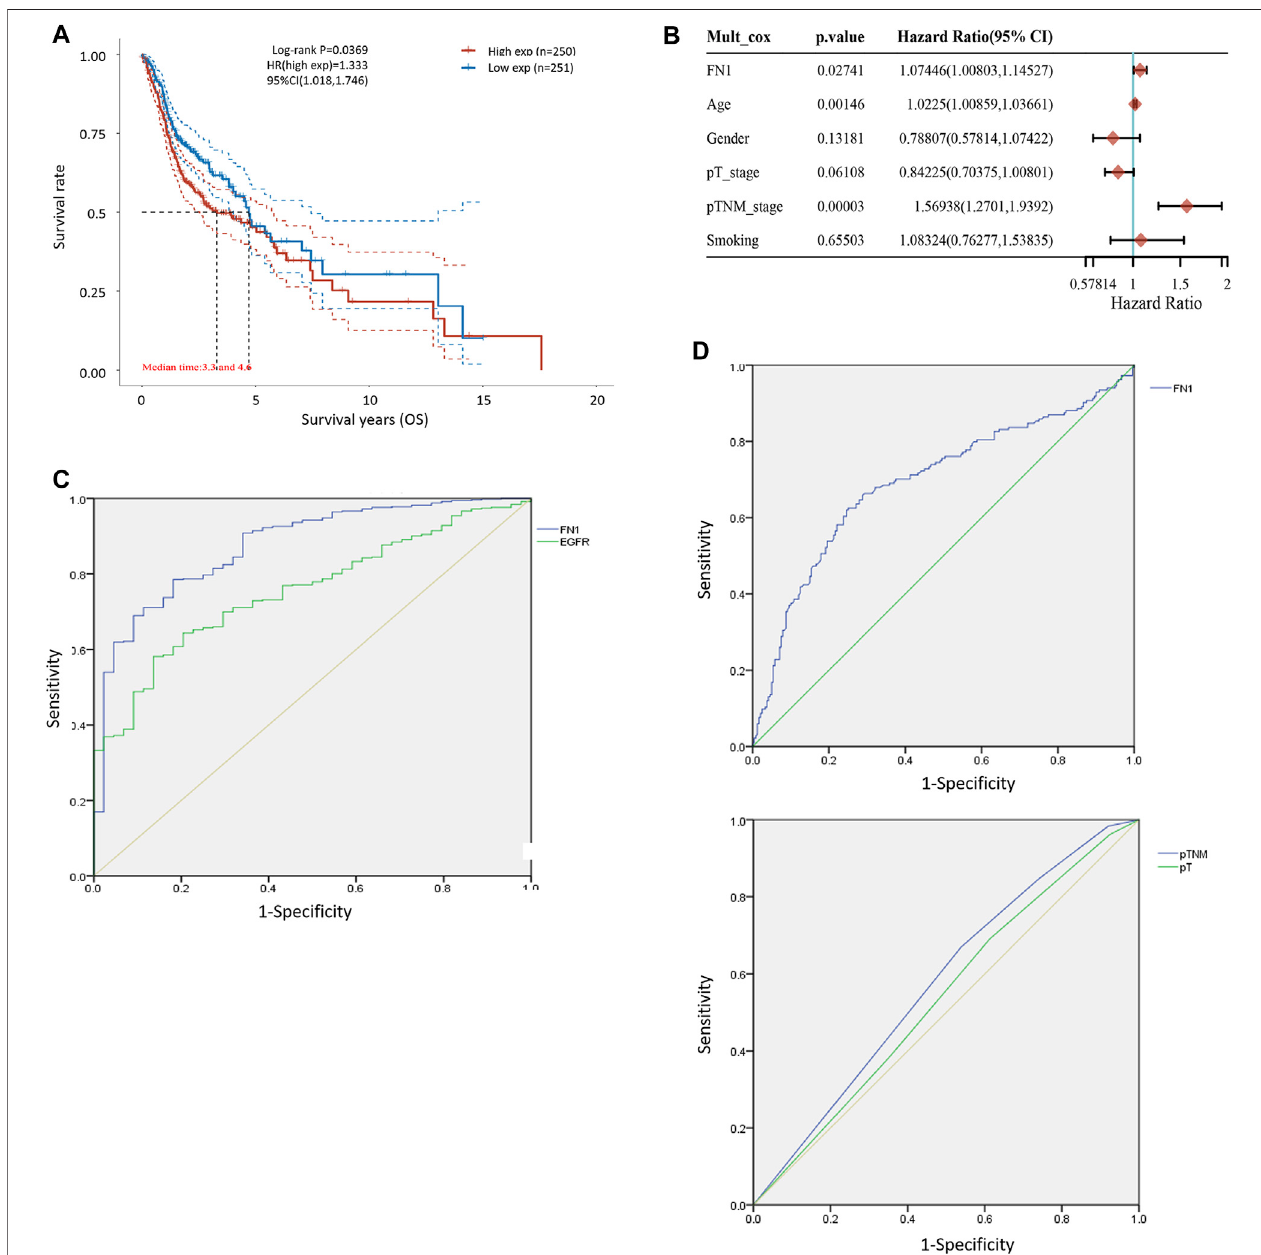
FIGURE2| Diagnosticand prognostic capability ofFN1 inHNSCC wasexaminedusing theROC curve. (A) KM survivalanalysisshowed thathigher expression of FN1 wasassociated with worse prognosis ofHNSCC patients. (B) Age, TNM classi fi cation, and FN1 expression were important prognostic factors for HNSCC patients examined by multivariate Cox analysis. (C) AUC of FN1 expression was higher than that of EGFR. (D) AUC of FN1 expression (upper) was higher than that of TNM classi fi cation or the tumor stage (lower) .